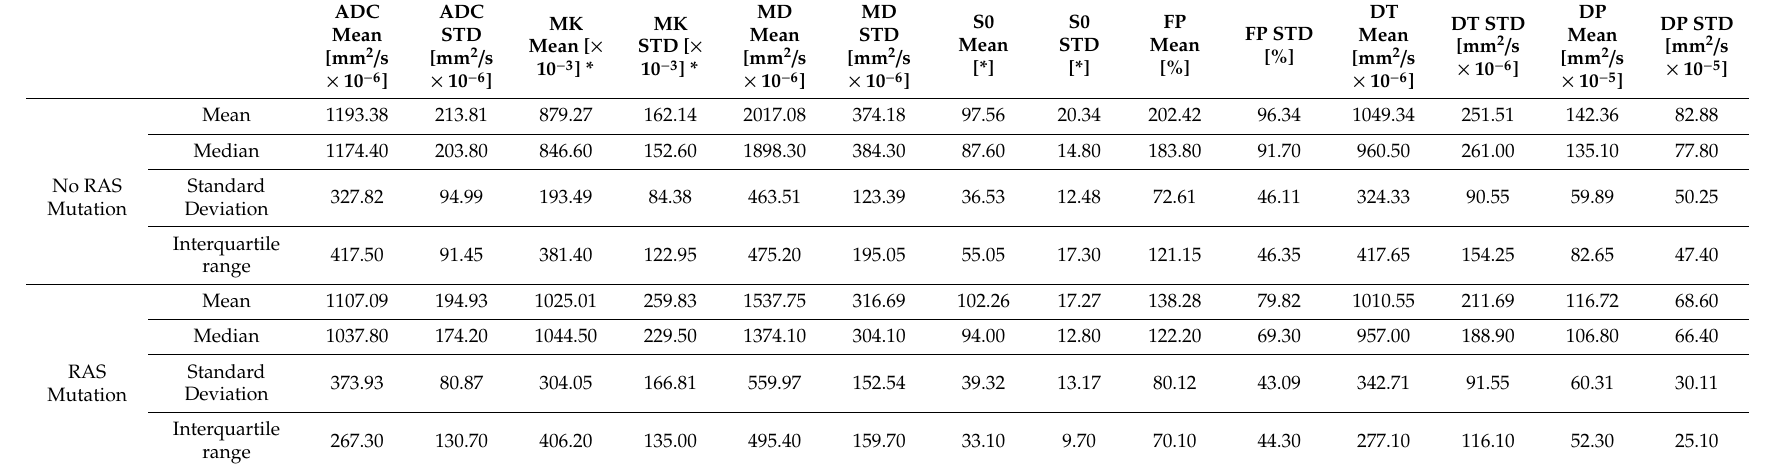
Table 3. Mean, median, standard deviation value (STD) and interquartile range for each of the derived parameters in the group with RAS mutation and in the group without RAS